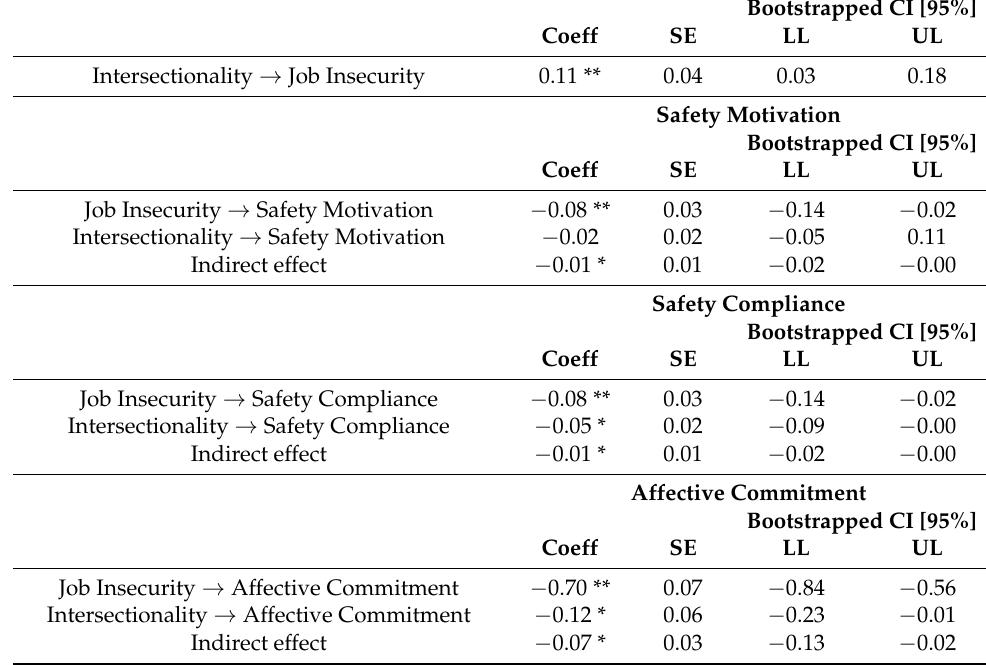
Table 2. The direct and indirect effects of intersectionality on